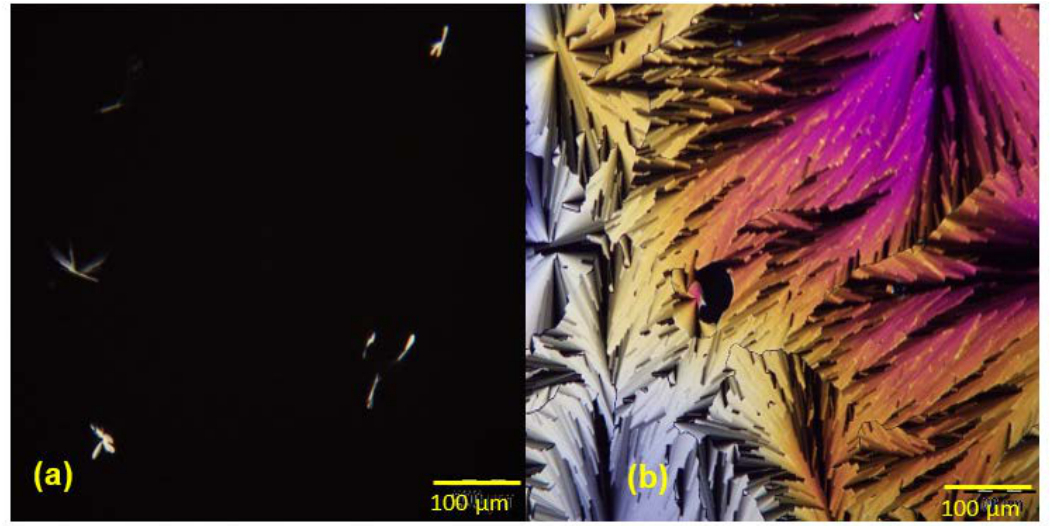
Figure 4. ( a ): Homeotropic growth of t -60 at 135 ◦ C (cooling rate: 1 ◦ C / min); ( b ): fan textures at 137 ◦ C (cooling rate: 1 ◦ C /